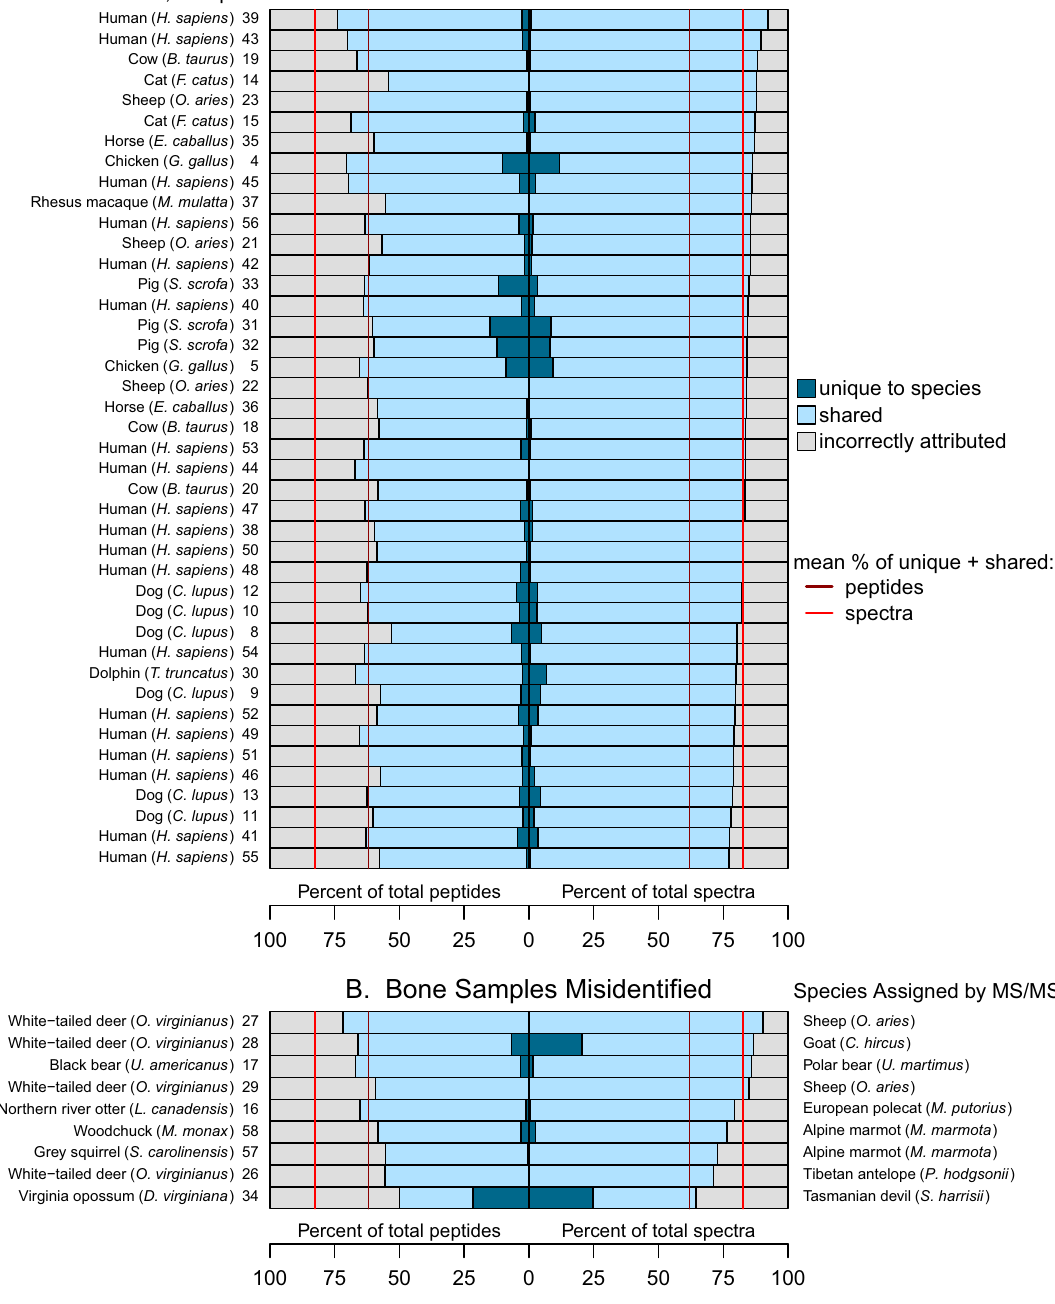
Figure 1. Proportion of peptides and spectra correctly and incorrectly attributed to sample species. Rows represent MS/MS data from each sample searched against an NR vertebrate database. ( A ) Sample species correctly identified. ( B ) Samples of known species misidentified due to poor database representation (Supplemental Table S5). Species assigned by MS/MS are listed on the right. Total number of peptides and spectra found for each sample can be found in Supplemental Table